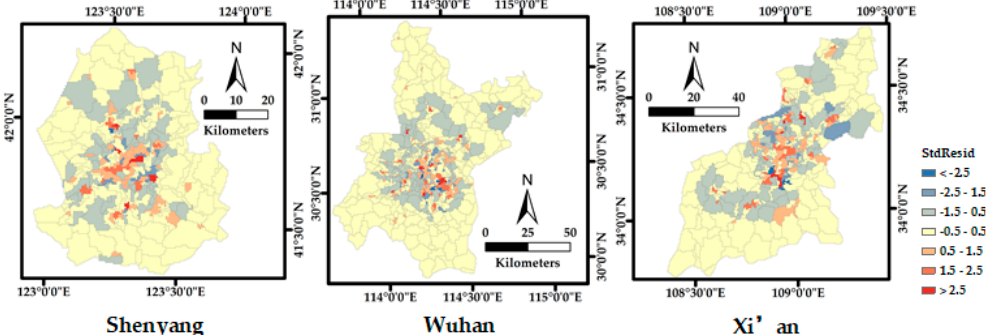
Figure 7. Geographically weighted regression (GWR) model. Table 2. Results of the GWR model.